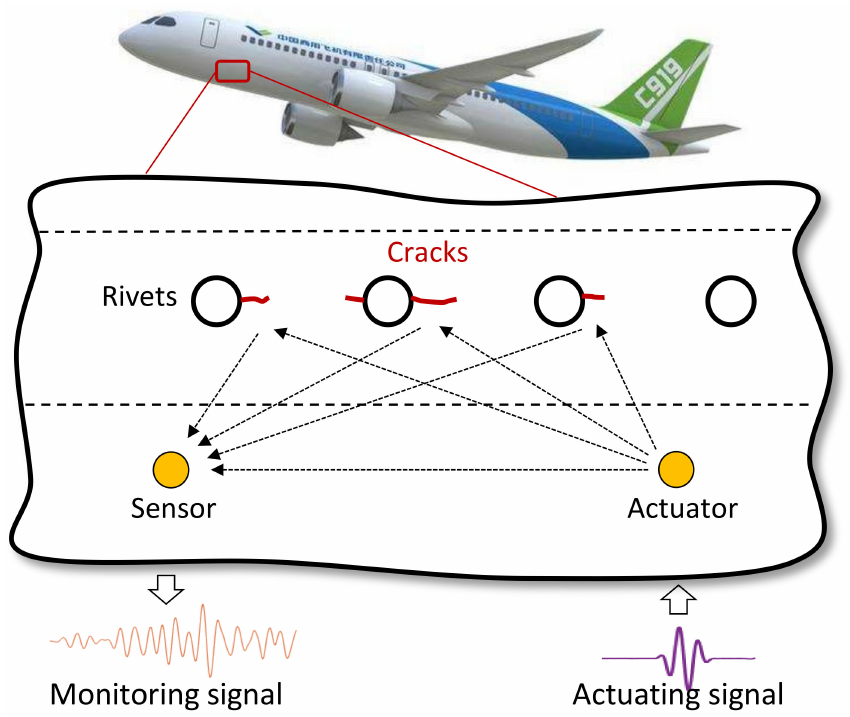
Figure 1. Illustration of the GW-based crack